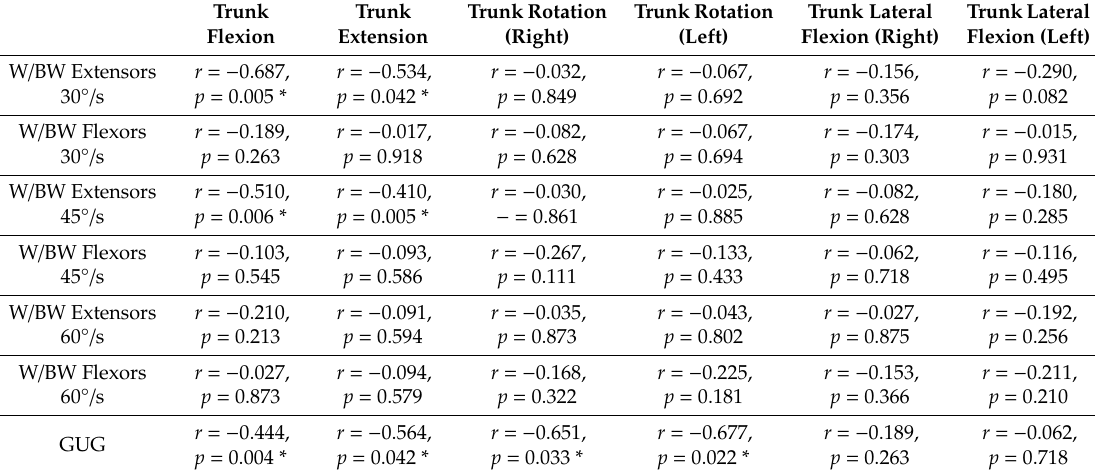
Table 3. Correlations between trunk ROM, trunk rigidity and functional